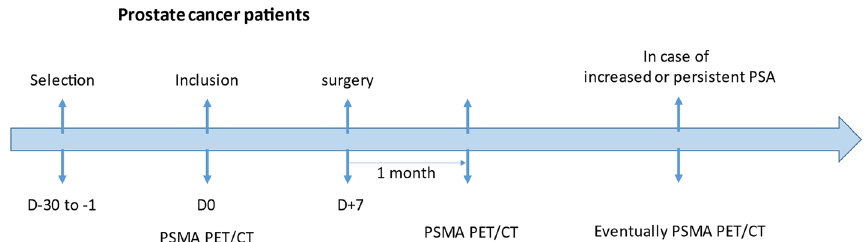
Fig. 1 Schematic representation of the